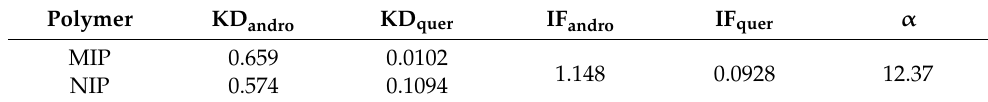
Table 3. Imprinting factor and selectivity factor of MIP and NIP. Polymer KD andro KD quer IF andro IF quer α MIP 0.659 0.0102 1.148 0.0928 12.37 NIP 0.574 0.1094